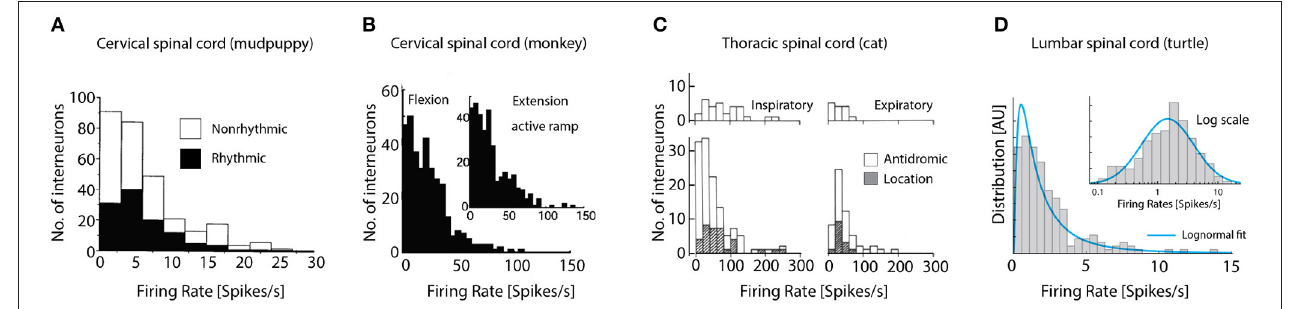
FIGURE 4 | Firing rate distributions across experimental preparations are skewed toward the origin. (A) The cervical CPG of the mudpuppy while performing locomotion, show rhythmic (black) and nonrhythmic discharge. (B) Cervical interneurons in macaque monkeys performing wrist flexion and extension. (C) Interneuronal recording from respiratory motor circuitry in the thoracic cord of cats. Left: inspiratory interneurons, right: expiratory interneurons. Top: identified by antidromic stimulation, bottom inclusion identification by location, white and hatched, respectively. (D) Lumbar spinal cord of turtle during scratching has skewed firing rate distribution (left) that is bell-shaped on log scale (blue fit). Reproduced with permission (A) Cheng et al. (2002), (B) Prut and Perlmutter (2003), (C) Kirkwood et al. (1988), and (D) Petersen and Berg (2016).